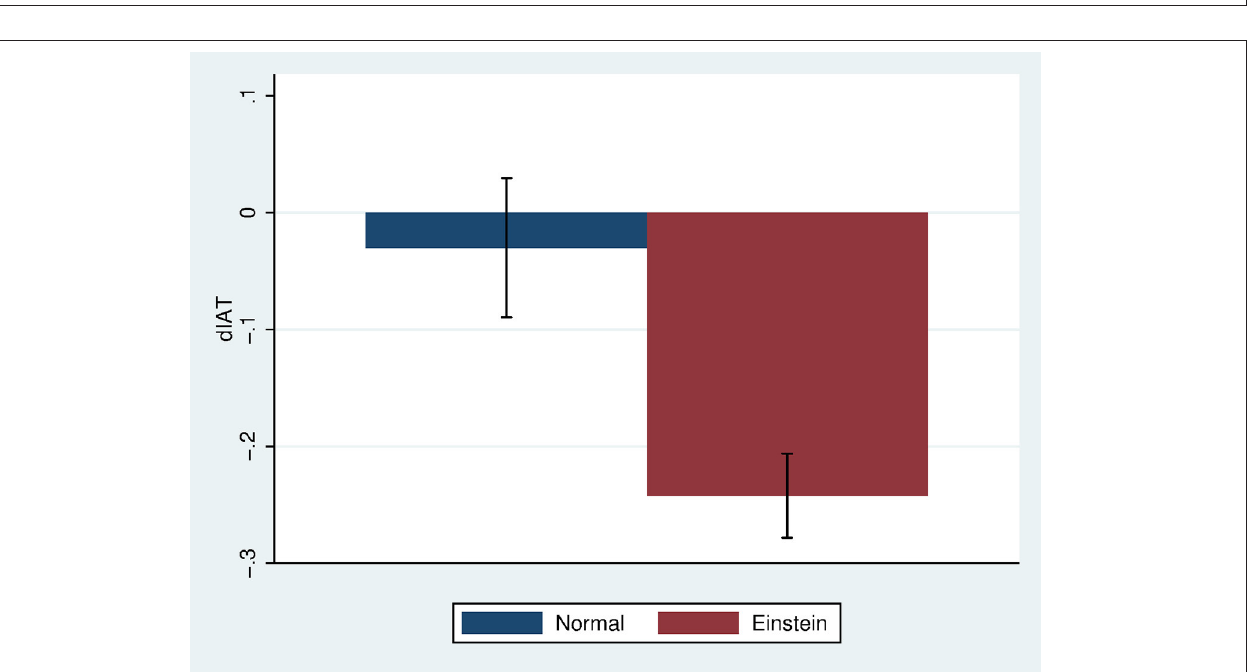
FIGURE 5 | Bar chart showing mean and standard error of diat by Body.